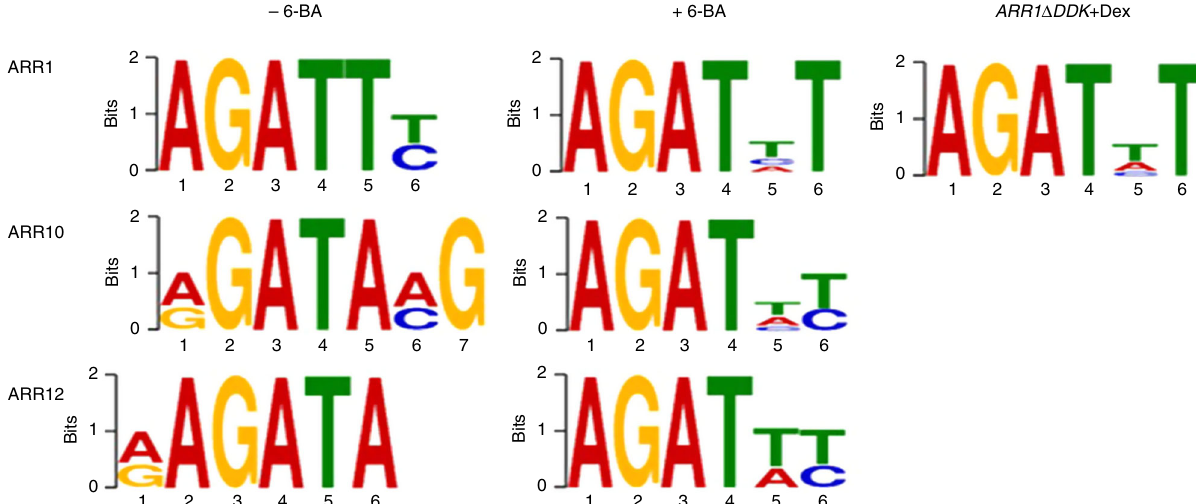
Fig. 5 Identi fi cation of the 6-BA dependent B-ARR binding motif. Similar DNA binding motifs of B-ARRs become nearly identical (B-ARR-6-BA motif) in response to increased cytokinin treatment (6-BA). AGAT is the core binding-motifs of B-ARRs and AGATHY, H(a/t/c), Y(t/c) are the B-ARR-6-BA